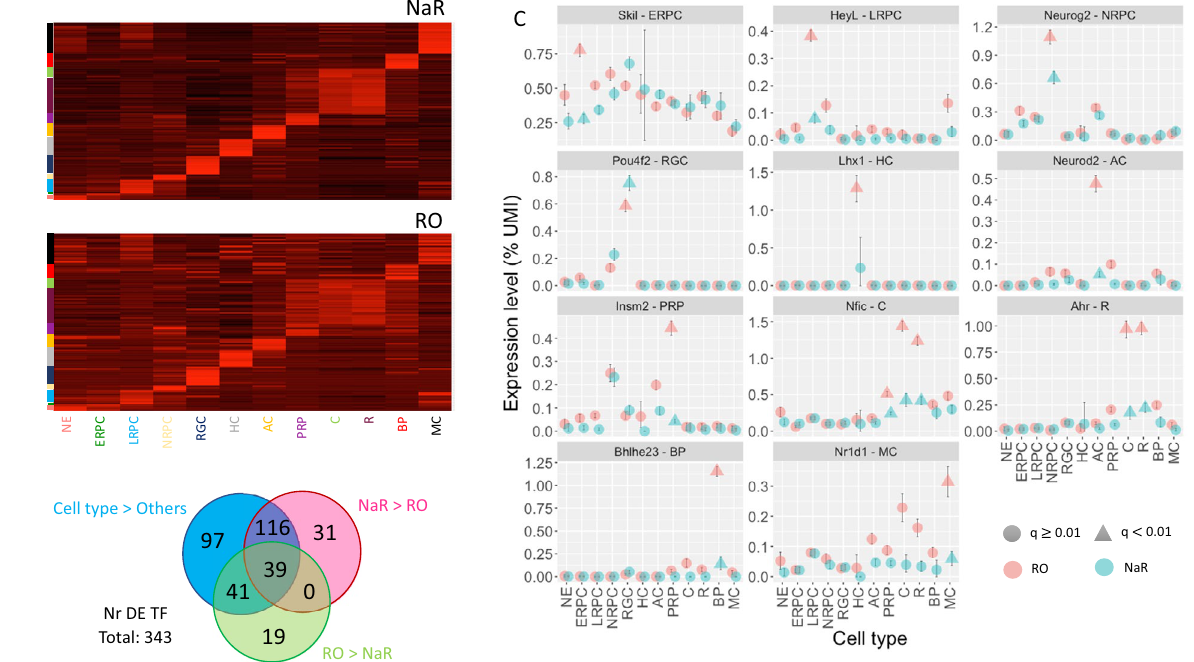
Figure 4. Comparison of the cell type-specific expression levels of TF in NaR and RO by means of scRNA-Seq. ( A ) Standardized expression levels of 107 most cell type-specific TF across 12 cell types in NaR (upper panel) and RO (lower panel). Abbreviations refer to cell types and are as defined in Fig. 1. ( B ) Number of differentially expressed TF in “Cell type > Others”, “NaR > RO”, and “RO > NaR”, with corresponding overlaps. The overlaps are highly significant (p < 10 –6 ) assuming that TF are sampled randomly from the full collection of ~ 1500 TFs 39 . ( C ) Examples of TF that are (i) significantly overexpressed in one cell type when compared to all others in NaR, and (ii) significantly under- or over-expressed in that cell type between NaR and RO. The average expression levels (fraction of UMI) of the corresponding genes in the different cell types are shown for NaR (green) and RO (red). The error bars correspond to 99% confidence intervals determined by bootstrapping (n = 1000). Triangles mark cell types in which the corresponding gene is significantly (q < 0.01, i.e. accounting for multiple testing) overexpressed in NaR when compared to all other cell types combined (green), in which the expression level differs significantly (q < 0.01) between NaR and RO (red). The gene name and cell type of interest are given in the facet